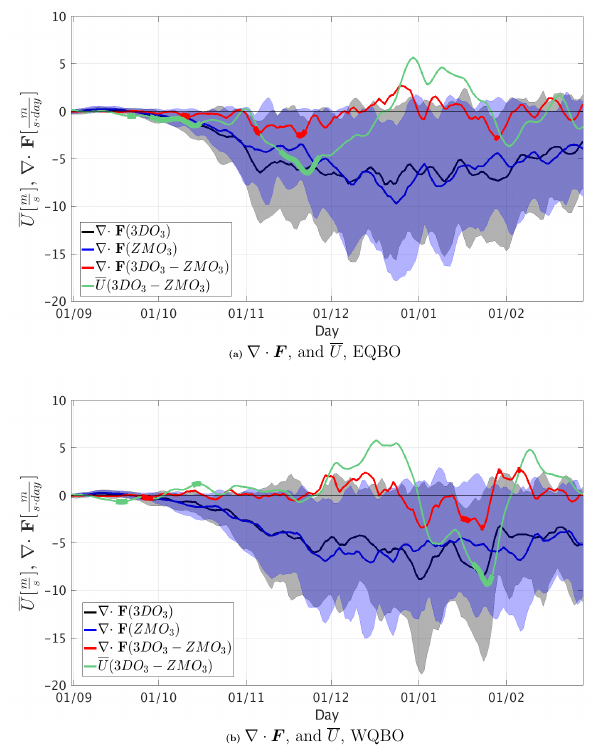
Figure 13. Daily climatology of EQBO (a) and WQBO (b) years (defined by October) averaged over 10–0.1mb, 85–45 ◦ N. The EP flux divergence is shown for the 3DO 3 run (black), the ZMO 3 run (blue), and their difference (red), with the difference between 3-D and ZM runs of the zonal mean zonal wind shown in green. Gray and blue shading indicated ± 1 standard deviation from the mean of the 3DO 3 and ZMO 3 runs, respectively. Statistical significance is indicated by a thick